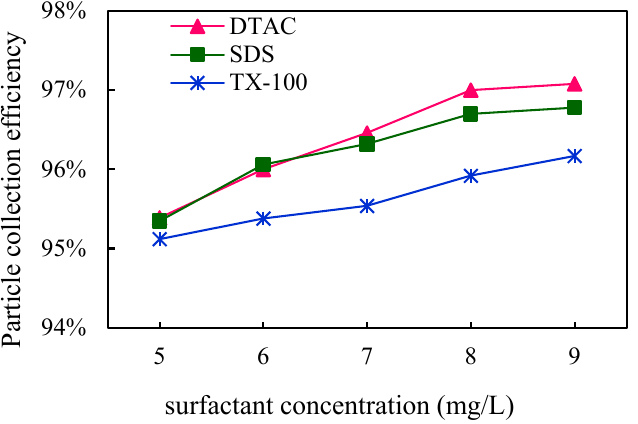
Figure 12. Effect of surfactant concentration on dust removal efficiency.